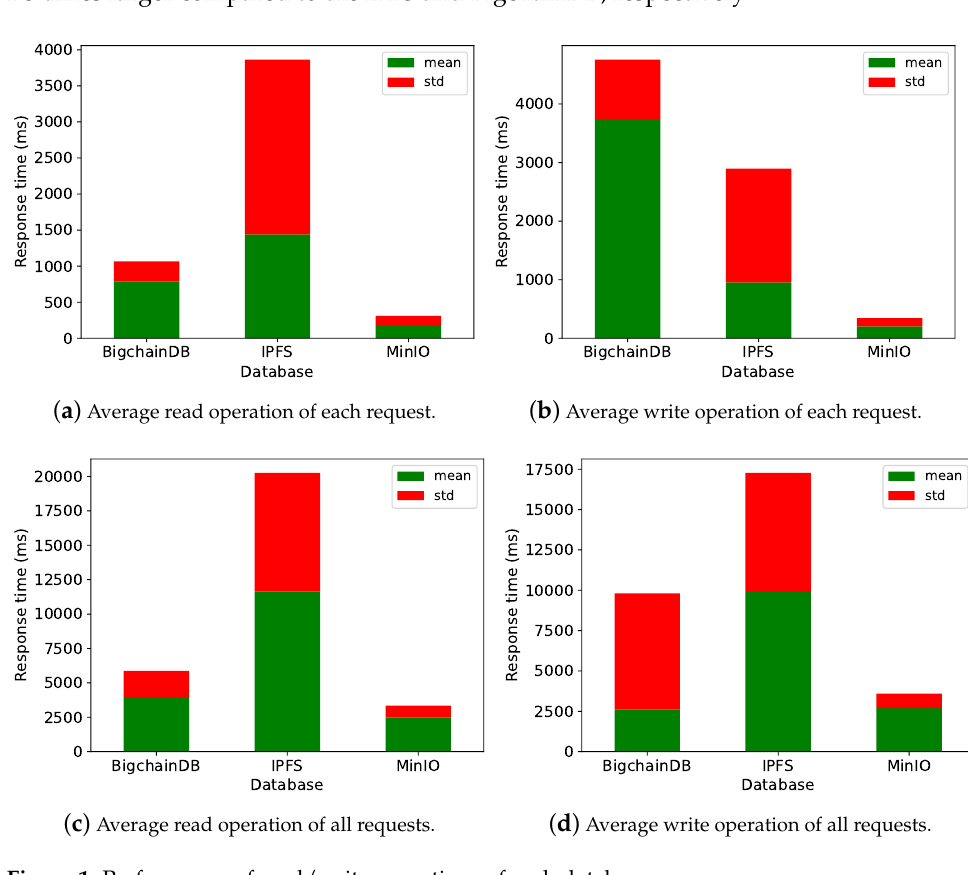
Figure 1. Performance of read/write operations of each